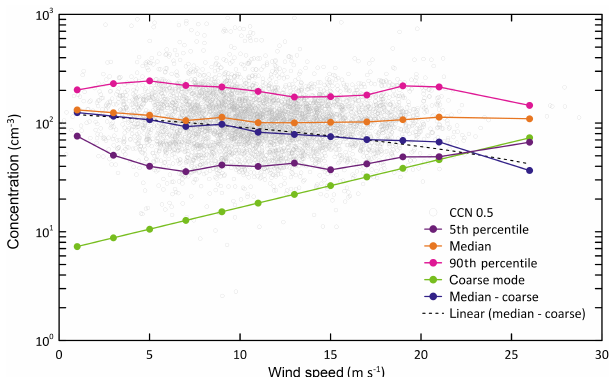
Figure 4. CCN0.5 concentration as a function of wind speed, sum- mer, radon <150mBeqm − 3 .